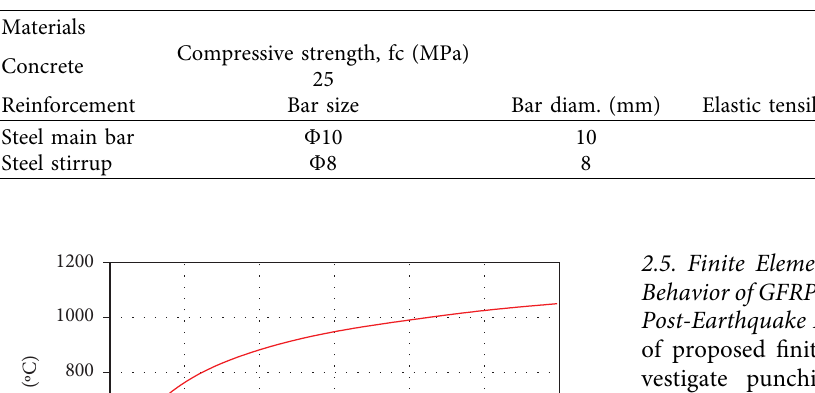
Figure 4: Reinforcement detailing of part-II specimen [11]. (a) Compression reinforcement. (b) Tension reinforcement. (c) Center line section. Table 3: Material properties of concrete and reinforcement [11].